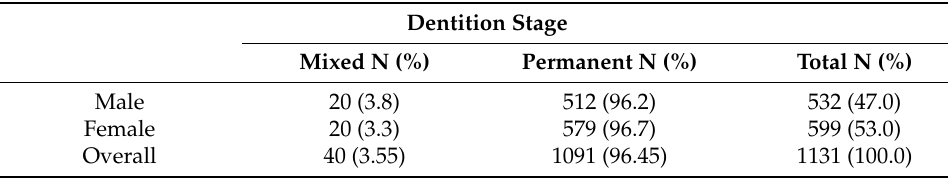
Table 6. Distribution of dentition stage between genders in